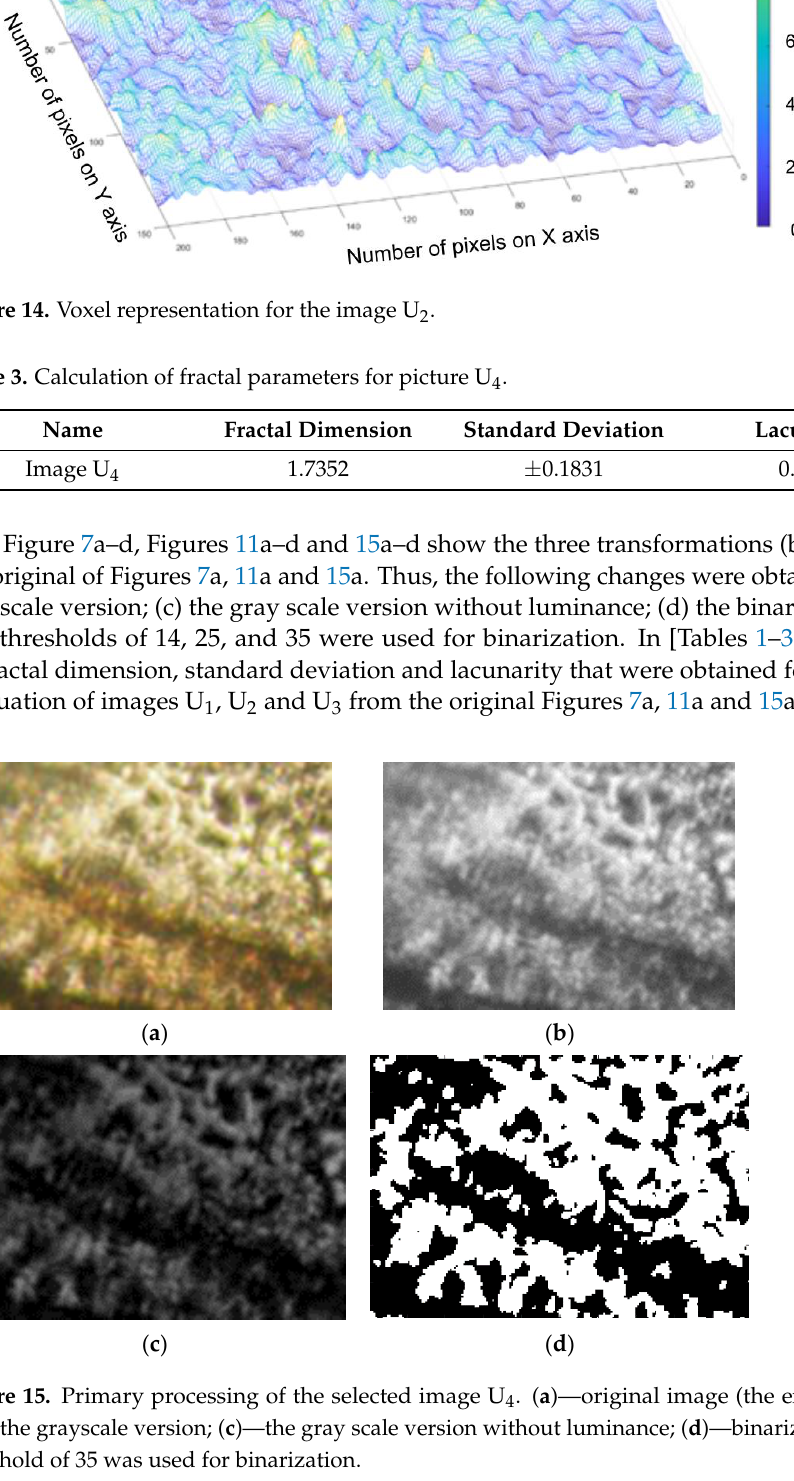
Figure 16. Box-count algorithm results: fractal dimension.